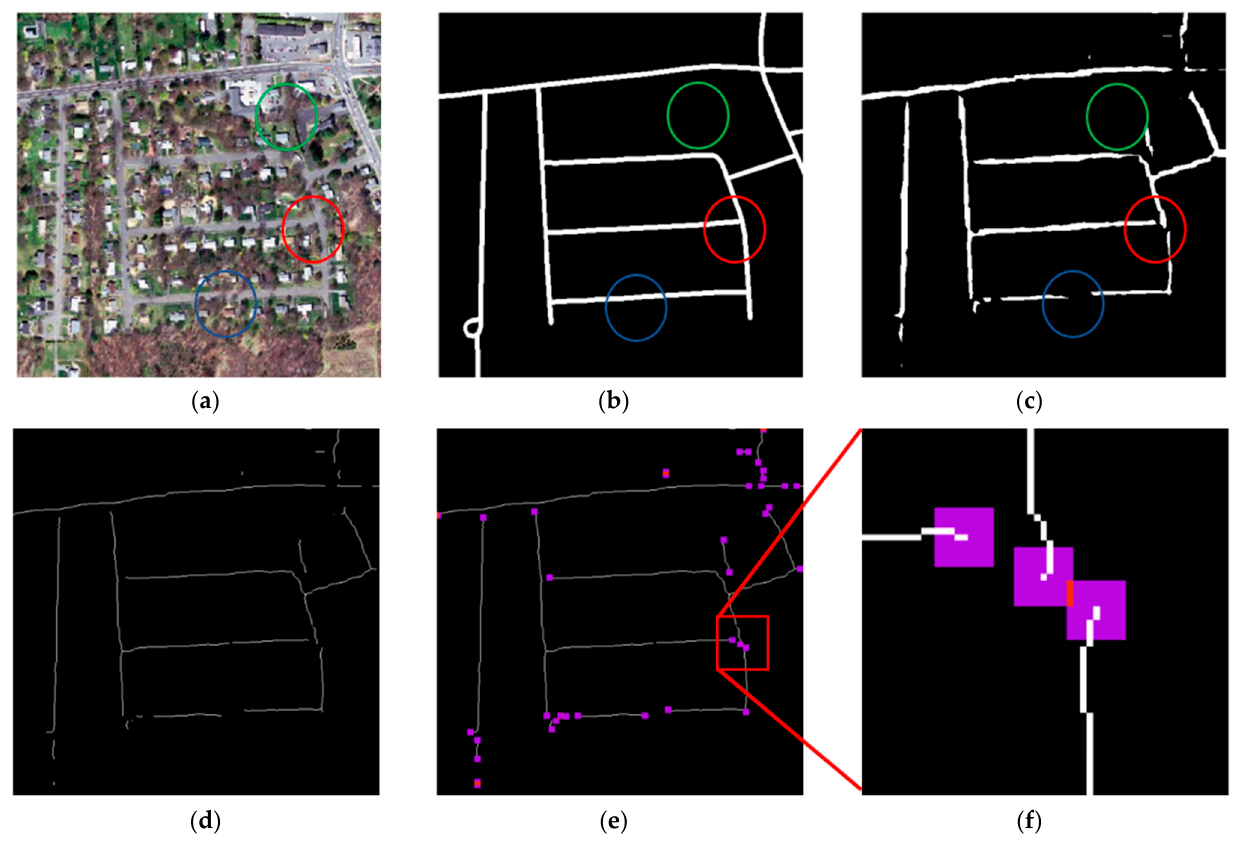
Figure 1. Calculation diagram of GapLoss. ( a ) Input remote sensing image, ( b ) corresponding label, ( c ) predicted road by deep-learning network, ( d ) skeleton of predicted road, ( e ) weight map by buffering of endpoint, and ( f ) a partial enlarged view of ( e ). In ( a – c ), the blue circle is the road covered by trees, the red circle is the road intersection, and the green circle is the unconnected road. The red square of ( e ) is the range of figure ( f ) in figure ( e ). The purple pixels in ( e , f ) represent the buffer area generated by the end point of the road, and the red pixels represent the overlapping area of the two end point buffers